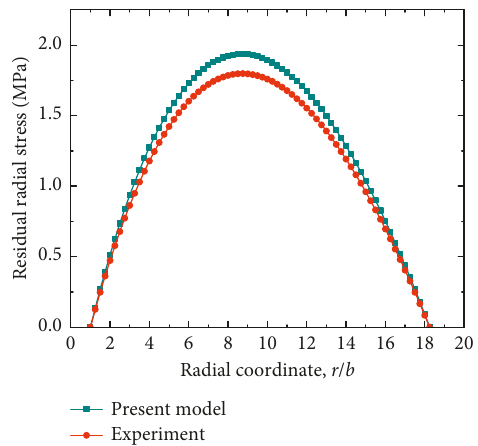
Figure 8: Residual radial stress of the composite wound cylinder after mandrel removal.